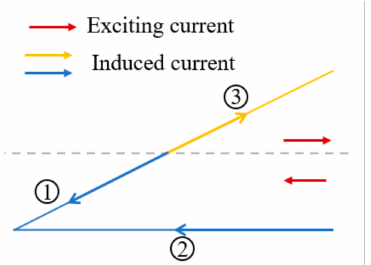
Figure 9. A schematic diagram of the inductive current directions in one triangular turn in Model 1.